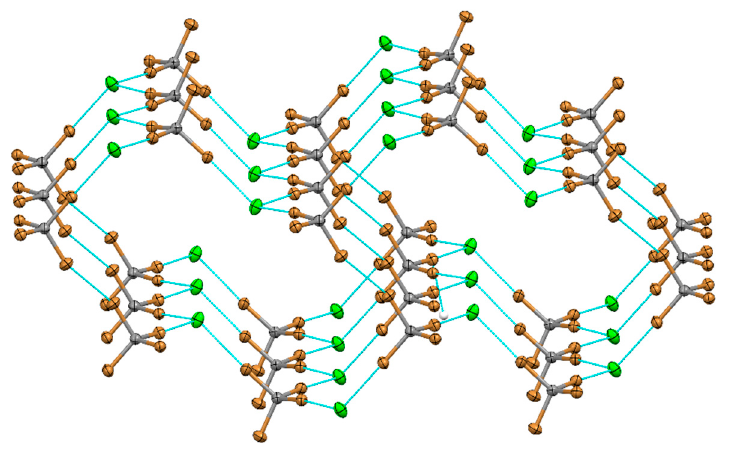
Halogen-bonded (XB) network formed by tetrabromomethane and Cl − anions in Figure 2. Halogen-bonded ( XB) network formed by tetrabromomethane and Cl − anions in (Pr 4 N)Cl · CBr 4 co-crystals (Pr 4 N)Cl·CBr 4 co-crystals 2.